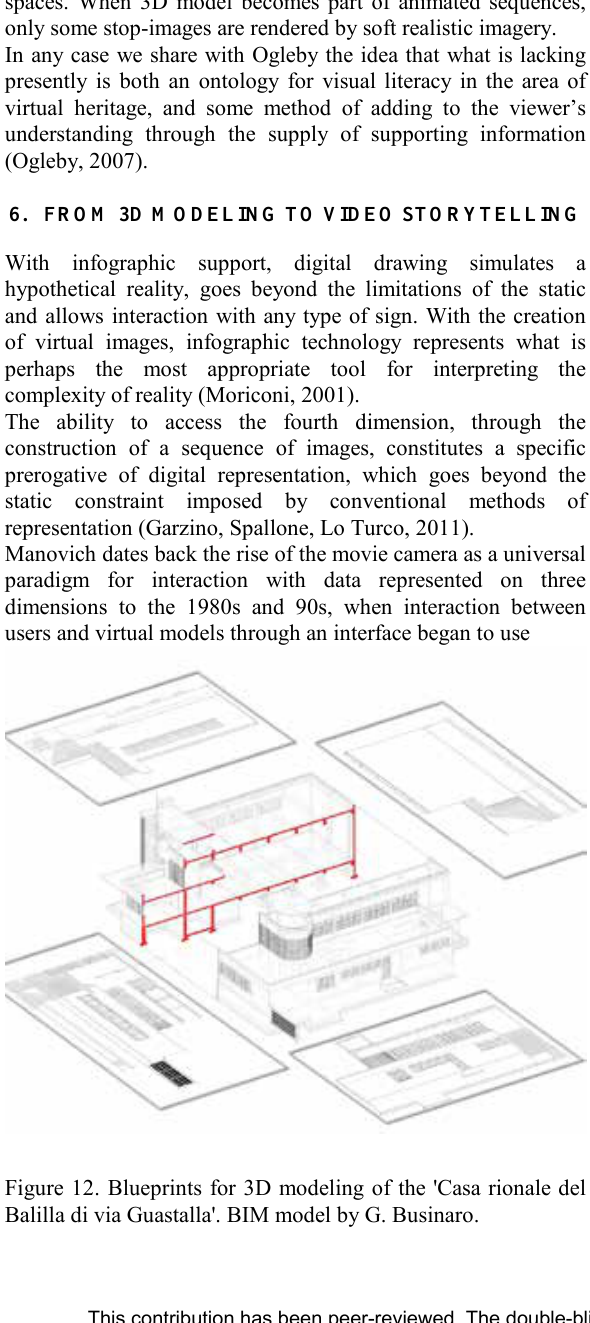
Figure 13. Comparison of digital reconstruction and current condition of the 'Casa rionale del Balilla di via Guastalla'. BIM model by G.